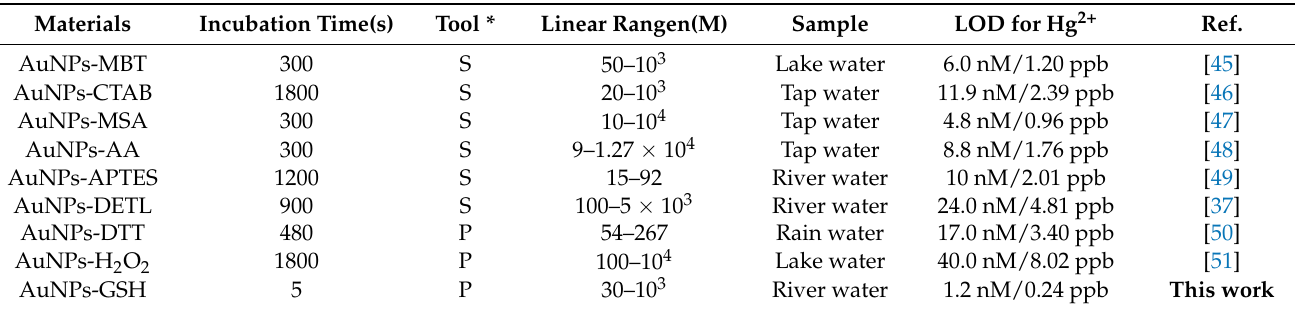
Table 2. Comparison between the practical application effect of the proposed colorimetric biosensor to Hg 2+ detection and the results of previously reported works.